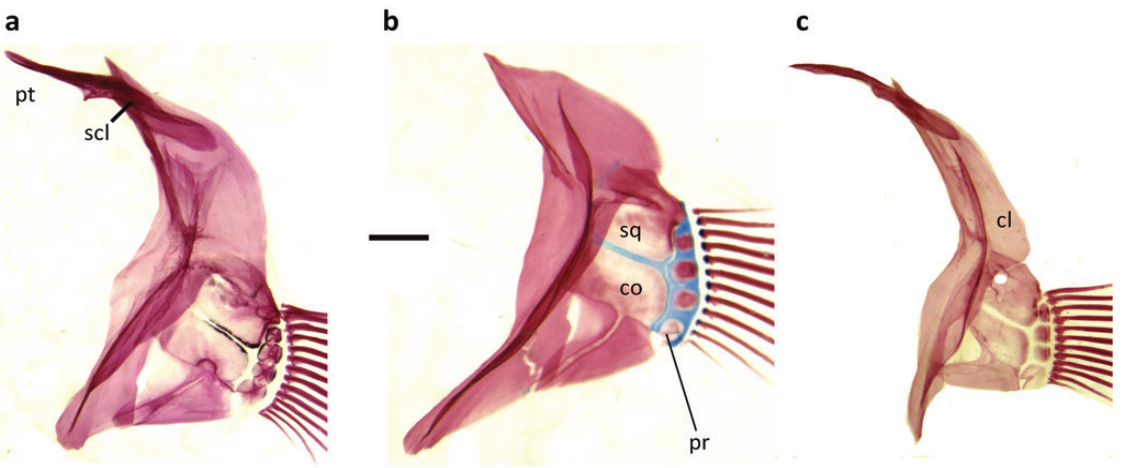
Fig. 8 . Pectoral girdle of a. Papiliolebias bitteri , b. Cynopoecilus melanotaenia , c. Ophthalmolebias constanciae ; cl = cleithrum, co = coracoid, pr = pectoral radial, pt = postemporal, scl = supracleithrum, sq = scapula. Scale bar = 1 rays in males (19–32); elongated dorsal portion of cleithrum (Fig. 8c); absence of posteroventral flange of cleithrum (Fig. 8c); ventral tip of cleithrum ventrally directed (Fig. 8c);